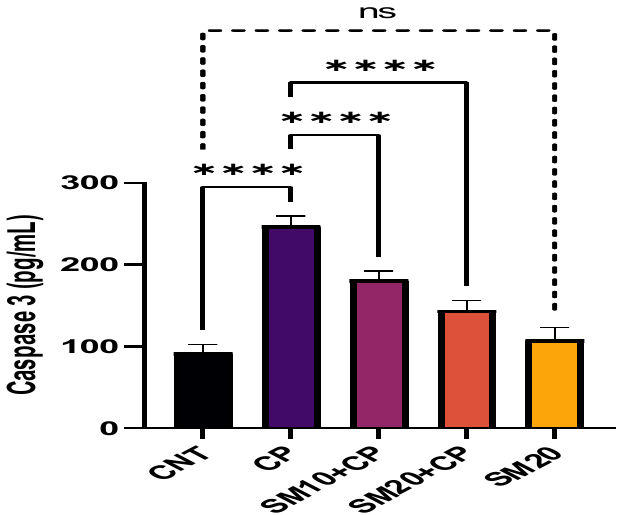
Figure 3. Protective effects of SM on renal apoptotic marker (Caspase 3) level against CP-induced nephrotoxicity. Value denoted in mean ± SD (n = 6). **** p < 0.0001 vs. CNT, **** p < 0.0001 vs. CP and ns p > 0.05 vs. CNT. Abbreviation; CNT: control, CP: cyclophosphamide, SM: sesamin.